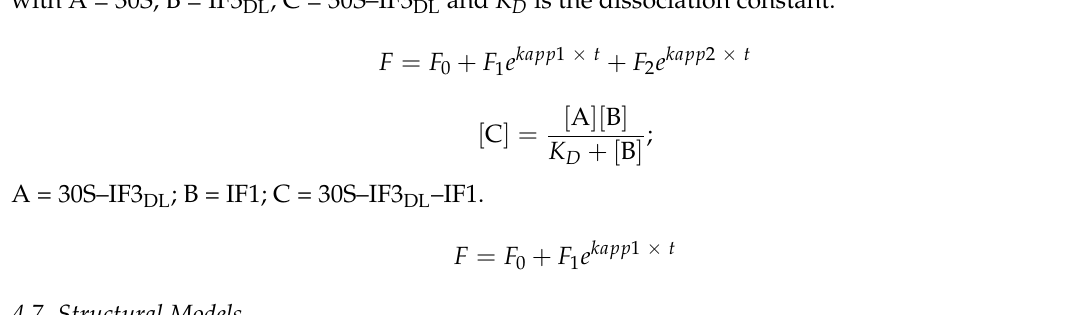
Table S1: Distances from h44 to h45 of residues in the engaged state, disengaged state, and IF1-bound structures, Table S2: Summary of structural counter effects between streptomycin and IF1 on the 30S subunit, Table S3: Structures used for modeling. Figure S1: Purification and fluorescence labeling of IF3 E166C , Figure S2: Purification of IF1, Figure S3: FRET controls for IF3 DL sensing of A-site binders, Figure S4: Possible structural changes induced by streptomycin and IF1 on the 30S